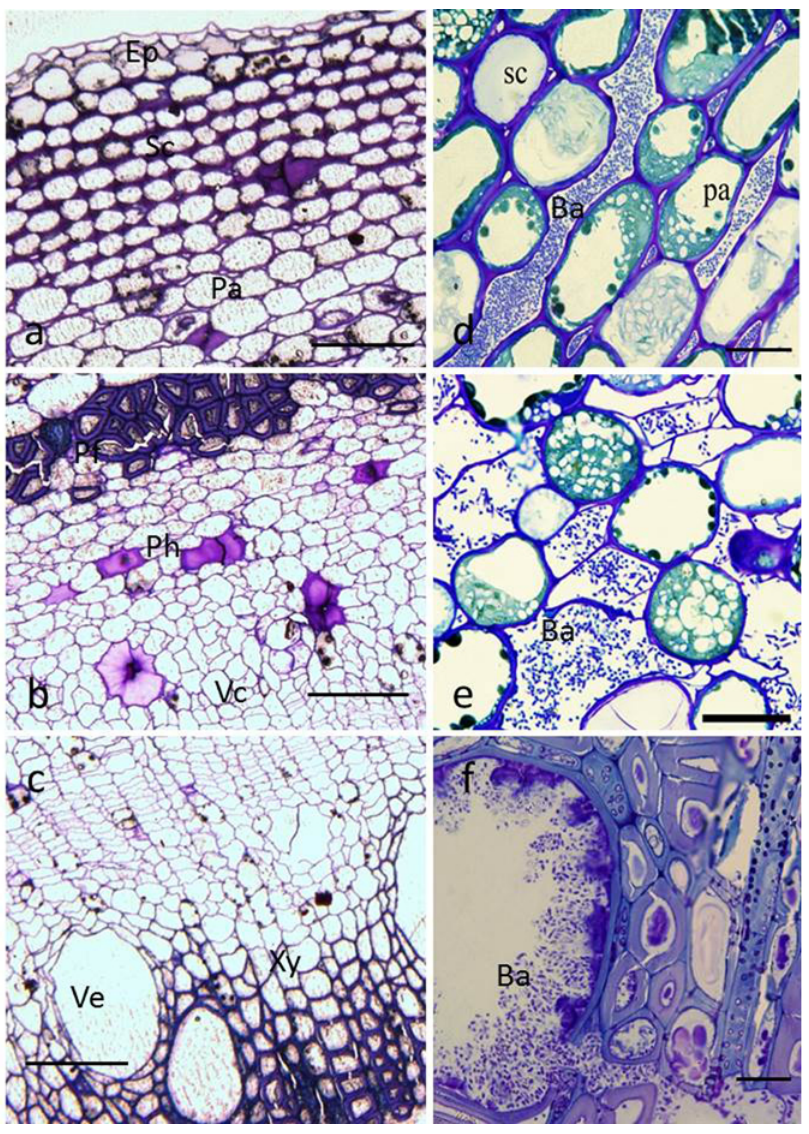
parenchyma (Pa), phloem fiber (Pf), phloem (Ph), vascular cambium (Vc), xylem (Xy), and vessel (Ve). Bar = 100 μ m. (d – f), transverse sections of inoculated bark. (d), bacterial cells (Ba) in intercellular spaces of parenchyma; (e), bacterial cells in phloem cells and intercellular spaces; (f), bacterial cells tightly packed within xylem vessels. Bar = 20 μ m.